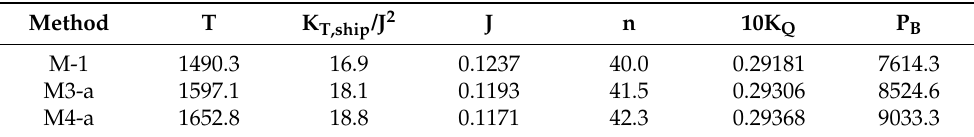
Table 4. Prediction of required propulsion power using #2 propeller.